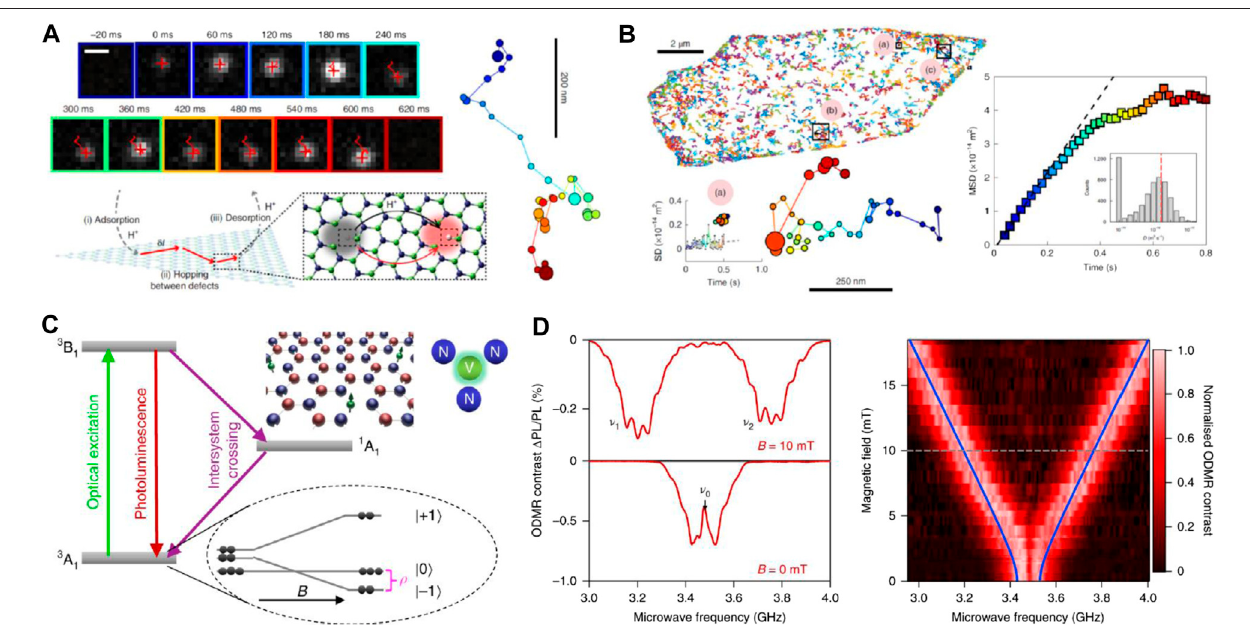
FIGURE 3 | Proton transport and quantum sensing in hBN. (A) Top left: time series for spatial migration of luminescence at the surface of the hBN fl ake, detected withwide- fi eldSMLM(scalebar500 nm;projectedpixelsize100 nm).Right:Reconstructedtrajectoriesshowingsuccessiveactivationofadjacentdefectsatthesurface of the fl ake and color-coded with increasing time. Localized defects are represented as dots, with the radius corresponding to the localization uncertainty. Bottom left: schematic depicting luminescence migration events, consisting of successive proton adsorption, diffusion and proton desorption from the surface. (B) Top left: large-scale mapping of proton trajectories (200 ms) measured at the surface of the hBN fl ake. Bottom left: representative proton trajectory with the corresponding evolution of the square displacement (SD). Right: variation of the mean square displacement (MSD) as a function of time for the hBN fl ake. The dashed line is a linear fi t from which the averaged diffusion coef fi cient is extracted D (cid:2) 2.8 × 10 – 14 m 2 s − 1 . Inset: distribution of the diffusion coef fi cient determined on individual trajectories, with the vertical dashed line being the average value. (C) Energy level scheme and atomic structure of the hBN V − B center; note the triplet ground state of multiplicity m s (cid:2) 0 and m s (cid:2) ± 1, with a magnetic fi eld B lifting the m s (cid:2) ± 1 degeneracy. (D) Optically detected magnetic resonance (ODMR) showing manipulation and read out of the spin state. The transitions m s (cid:2) 0 → + 1 and m s (cid:2) 0 → − 1 are shown by a drop in photoluminescence (ODMR contrast Δ PL / PL ) at the corresponding microwave resonant frequency. The dependence of the relative position between m s (cid:2) 0 and m s (cid:2) ± 1 is the basis of quantum sensing applications based on reading out the spin state of the V